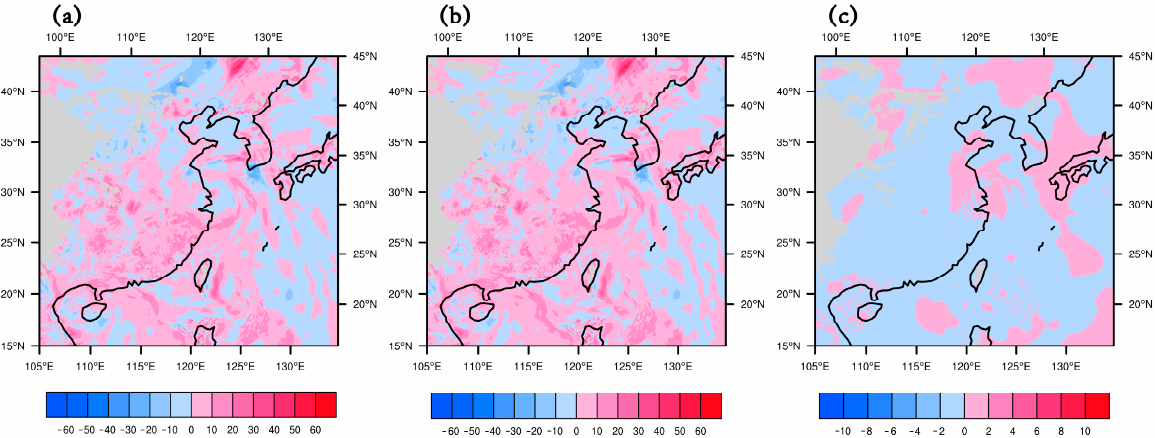
Figure 10. Relative humidity increment of ( a ) GTS, ( b ) MWHS2, and ( c ) the difference between GTS and MWHS2.